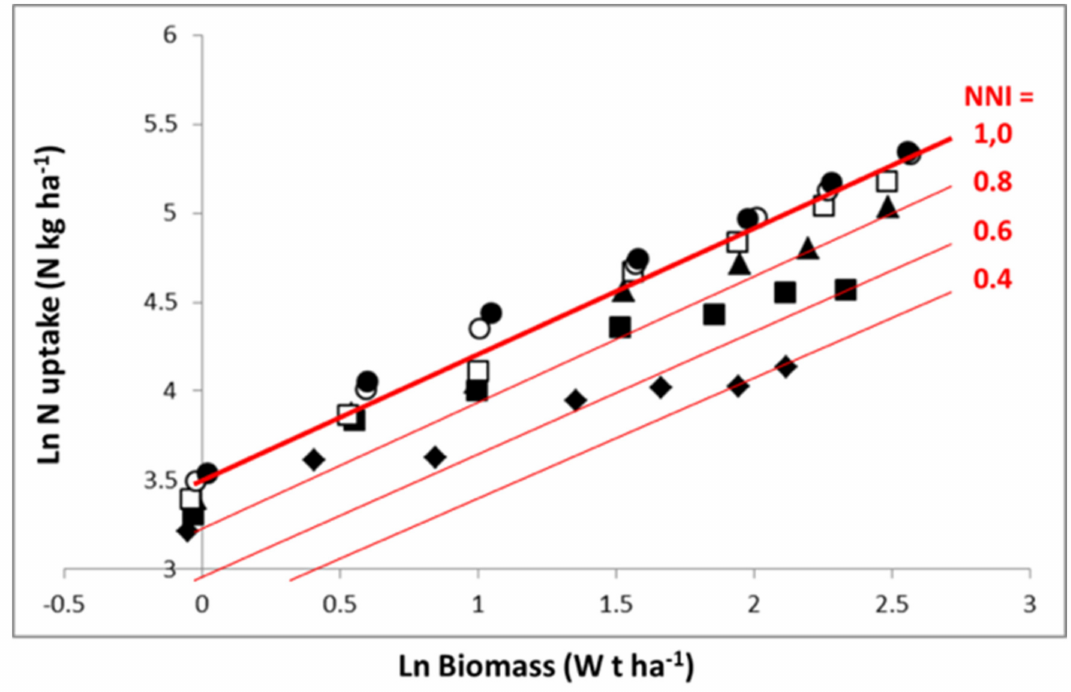
Figure 4. Representation of data of Figure 2 on a log–log scale (similar symbols). The thick red line denotes the critical N uptake curve for maize established by Pl é net and Lemaire [22], LnN = 3.5 + 0.64 LnW, and the thin red lines denote the N–W trajectories corresponding to limiting and constant N availability with nitrogen nutrition index (NNI) of 0.8, 0.6, or 0.4. Symbols are the same as in Figure 2, representing di ff erent levels of N fertilizer application